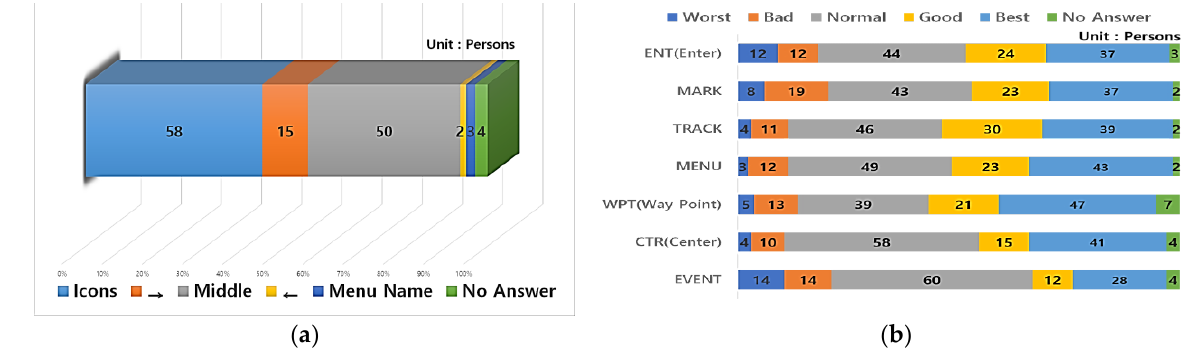
Figure A1. ( a ) Preference to apply function key for icons or menu terms; ( b ) Understanding of navigation-related terms and abbreviations.